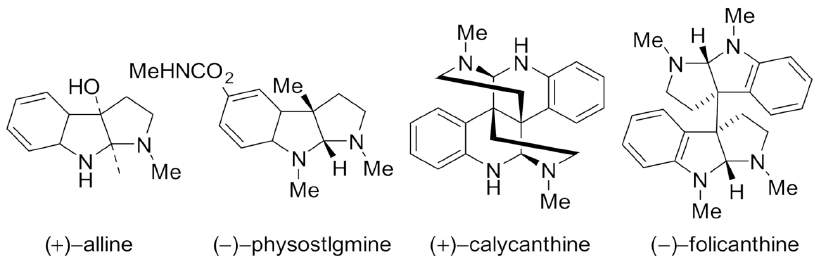
Figure 1. Structure of cyclotryptamine